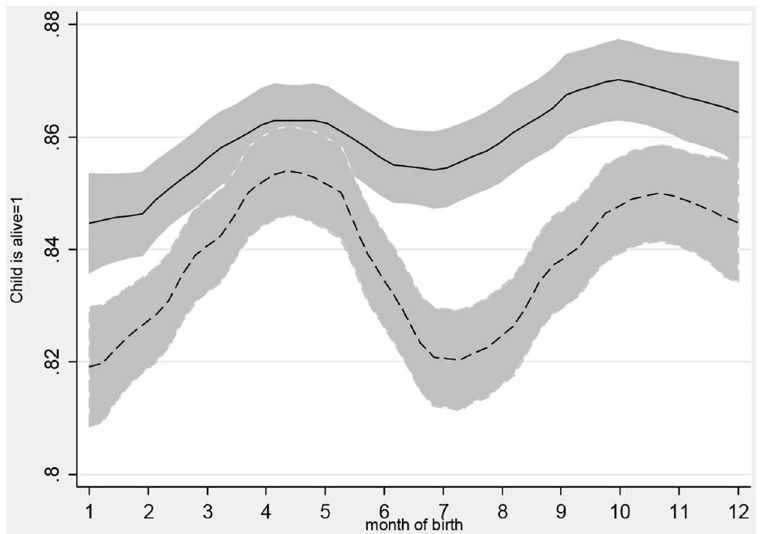
Fig 4. Child survival by month of birth and household remoteness. Notes: A local polynomial smoothing regression of whetherthe child is alive at the time of the survey for births in each month of the year, stratified by place of residenceand the presenceof seasons. Remote with seasonsis dashed line. 95% Confidence Intervals